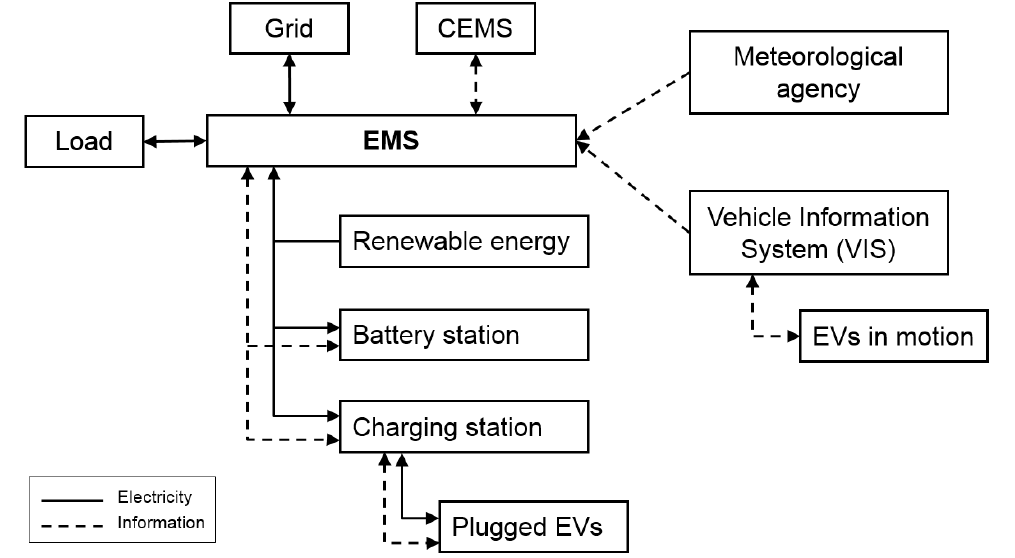
Figure 3. Basic schematic diagram of EVs and their used batteries integration to